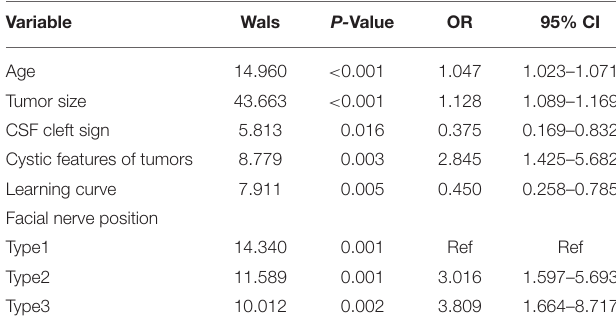
TABLE 3 | The multivariate logistic regression analysis of facial nerve outcomes after surgical resection of vestibular schwannoma.